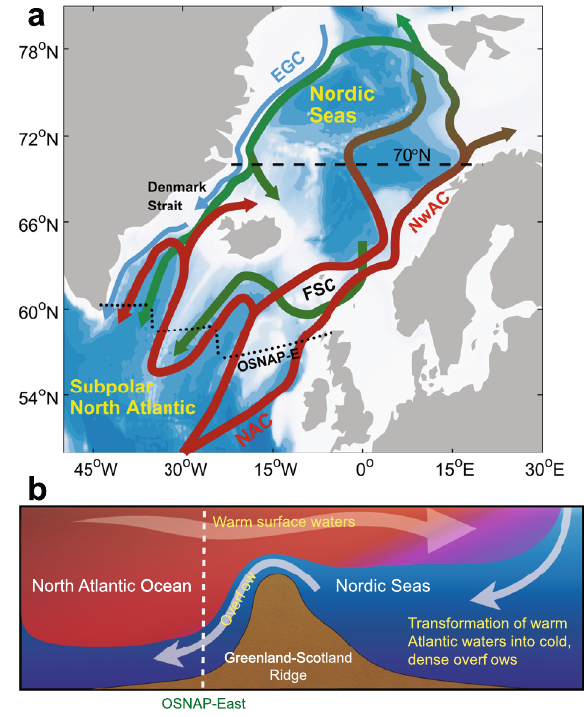
Fig. 1 | Ocean circulation of the eastern subpolar North Atlantic Ocean and Nordic Seas. a Schematic of the major ocean currents crossing the Greenland- Scotland Ridge (GSR). The arrows represent the pathways and transformation of warm Atlantic waters (red arrows) in the NAC-NwAC to cold, dense over fl ows (green arrows) that exit the Nordic Seas through the Denmark Strait and Faroe- Shetland Channel (FSC). The cold, fresh East Greenland Current (EGC) is shown by blue arrows. The sections at 70°N and in the eastern subpolar North Atlantic (mimicking the eastern part of the array from the Overturning in the Subpolar NorthAtlanticProgram 13 ;OSNAP-East)usedtocalculateoverturningcirculationare shown as dashed black lines. NAC: North Atlantic Current, NwAC: Norwegian AtlanticCurrent. b Schematicrepresentationofthemeridional fl owacrosstheGSR highlightinghowthedenseover fl owwatersfromtheNordicSeascontributetothe lower limb of the overturning circulation at